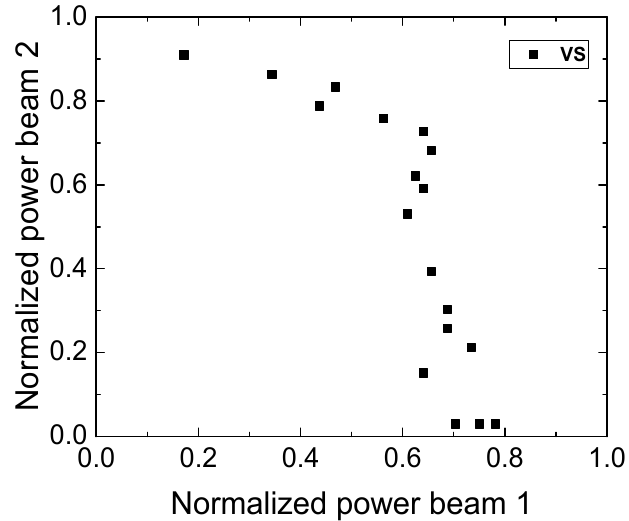
Figure 8. 2-BIT data for the polymer VS prepared at room